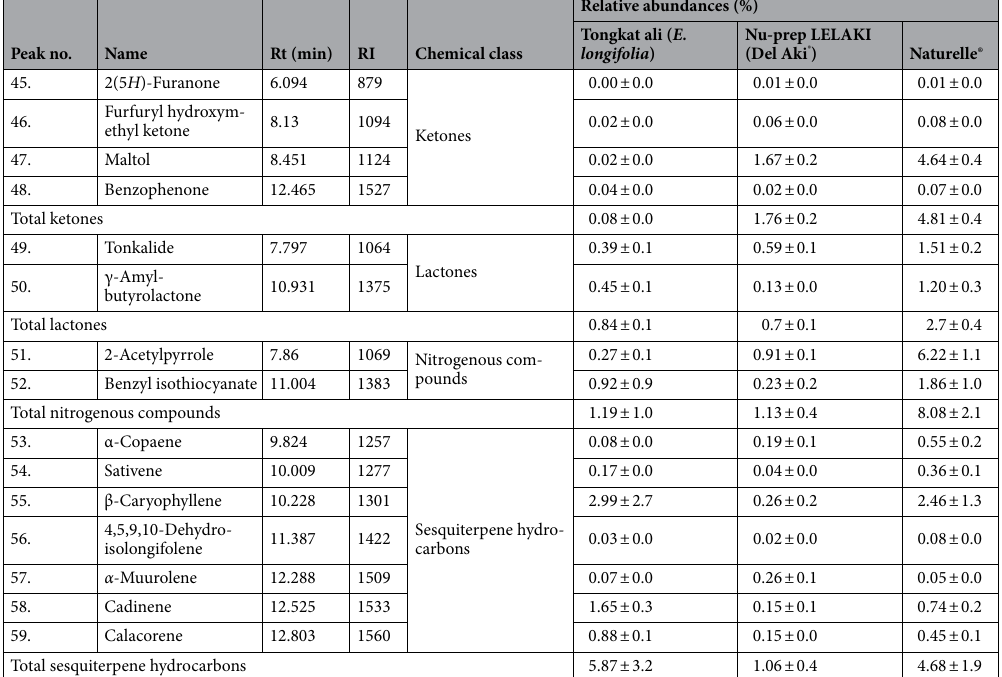
Table 2. Relative abundances (%) ± SD of volatiles detected in tongkat ali dried powder ( Eurycoma longifolia ) analyzed via SPME coupled with GC/MS in comparison with the marketed products, i.e., Nu-prep LELAKI and Naturelle (n =